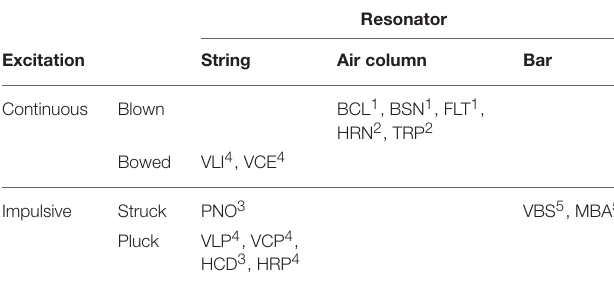
TABLE 4 | Instrumental categories based upon excitation and